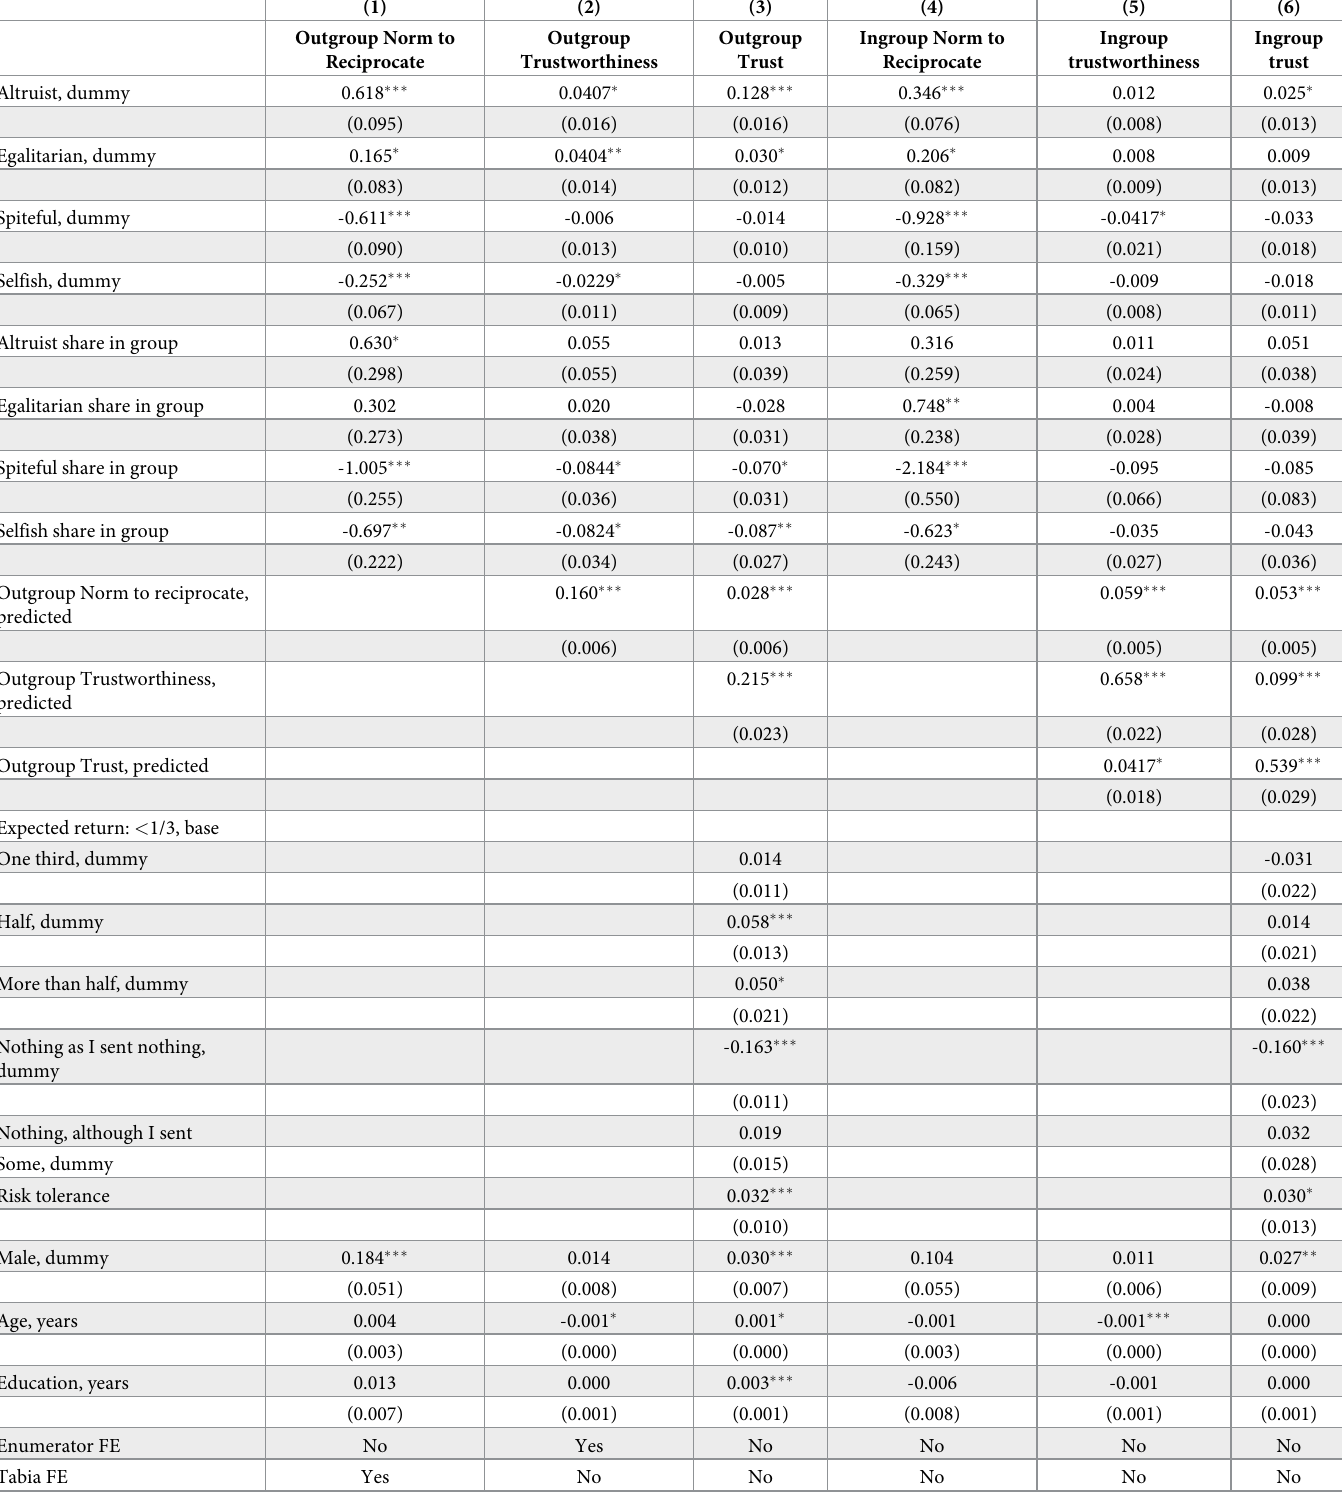
Table 8. Structural equation model: With group mean proportions of social preference types and gender, age, and